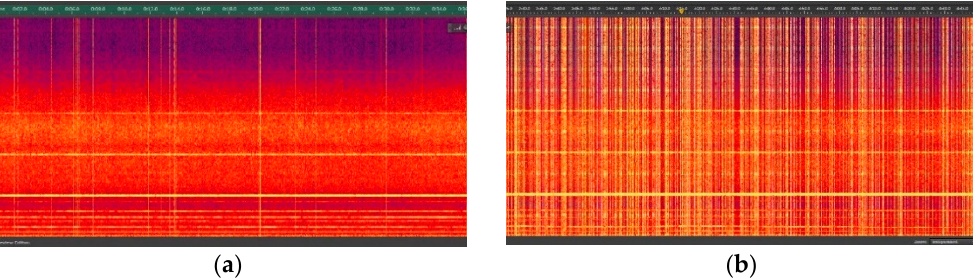
Figure 8. Contrasting nature of cavitation in two cases with very similar generator frequency, in ( a ) 9.32 kHz, in ( b ) 9.42 kHz obtained in a crucible with internal diameter 140 mm (remembering the vibration frequency in the coil will be doubled in the melt (10)).